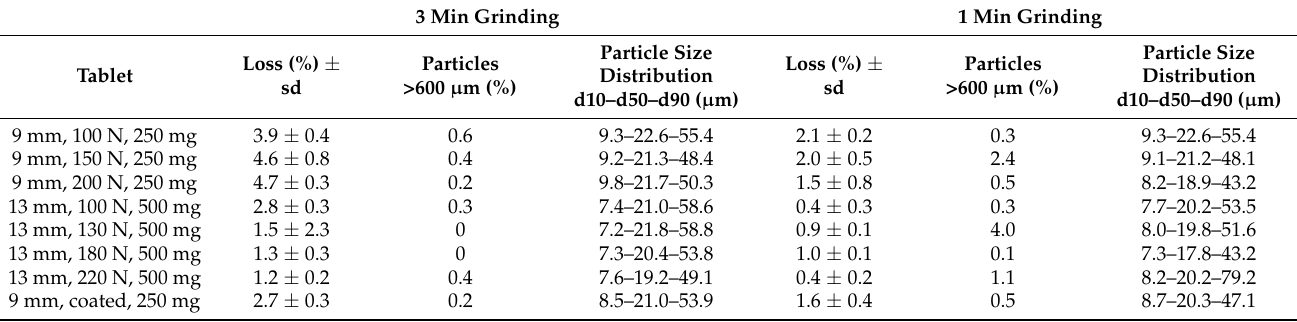
Table 7. Performance of electric grinder IKA. Of each type, 3 times 10 tablets were ground in one run for either 3 min or 1 min, at 25,000 rpm, and the obtained powders were pooled for particle size analysis. Percentage loss (mean ± sd, n = 3), particle size fraction >600 µ m, and particle size distribution of the fraction <600 µ